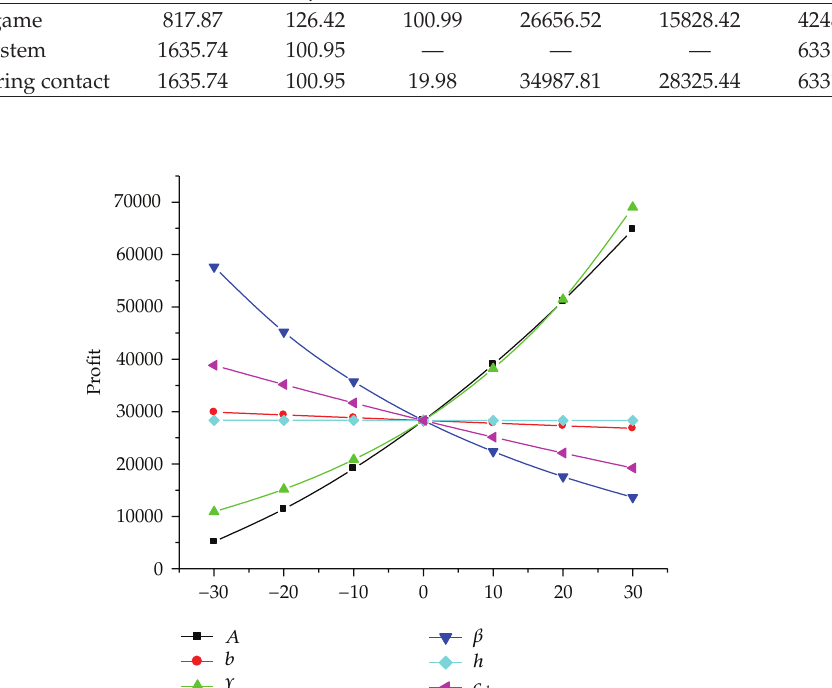
Figure 1: Behavior of retailer’s profit functions with respect to percentage of change in parameters value.